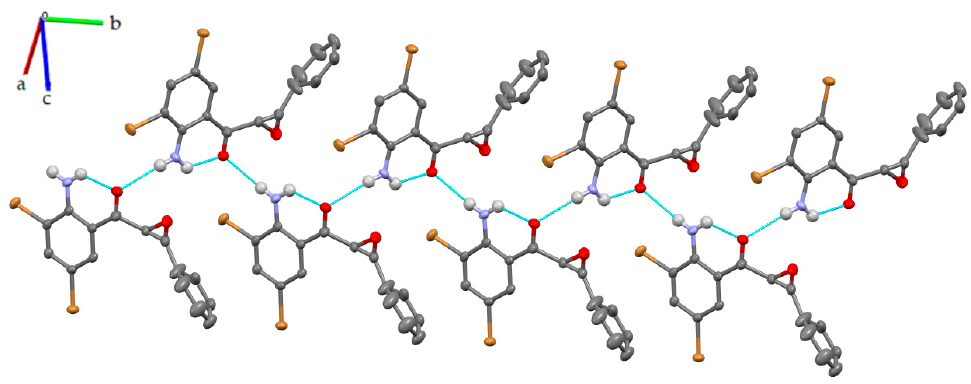
Figure 5. Intra- and intermolecular hydrogen bonding interactions for compound 2a. Table 1. Crystal data and structure refinement for compound 2a.